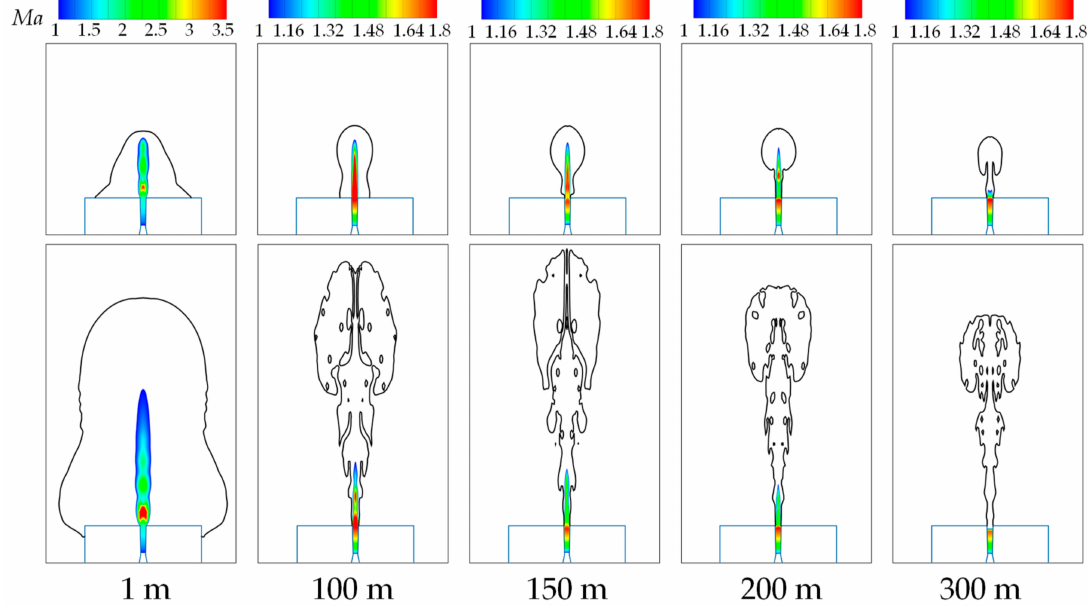
Figure 14. Numerical simulation at di ff erent working conditions (1 ms (up) / 10 ms